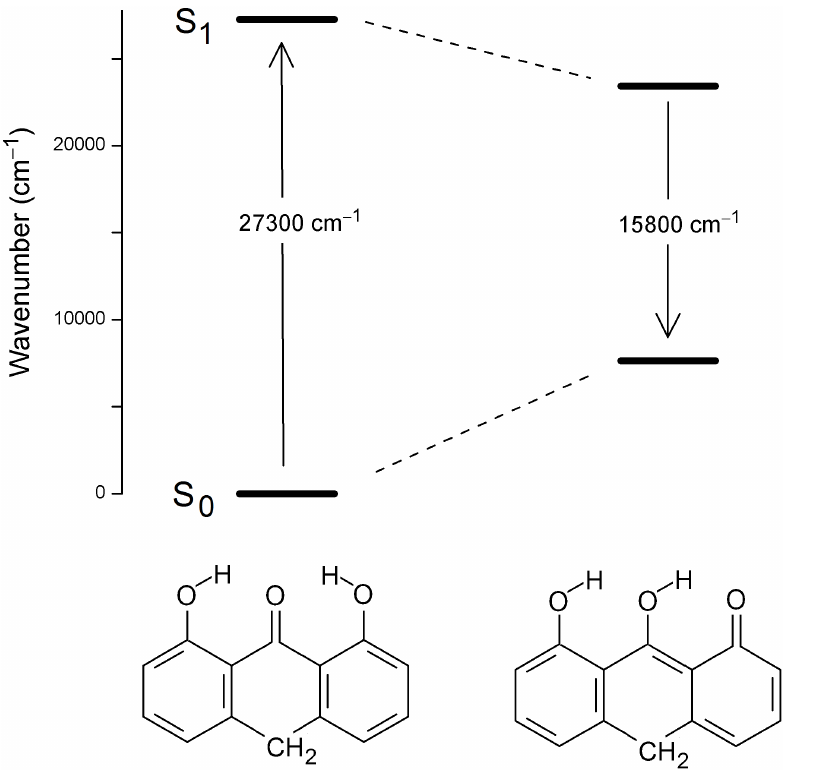
Figure 5 Predicted vertical excitation and emission wavenumbers for anthralin (A). On the left the predicted vertical transition from the ground state to the lowest excited singlet state is indicated, to the right the vertical emission from the photoproduct 8,9-dihydroxy-1(10 H )-anthracenone (TD-B3LYP/6- 31+G(d,p)). The predicted photoproduct is a result of barrier-less excited state intramolecular proton transfer (ESIPT). Further details are provided in Data S2 and Fig.